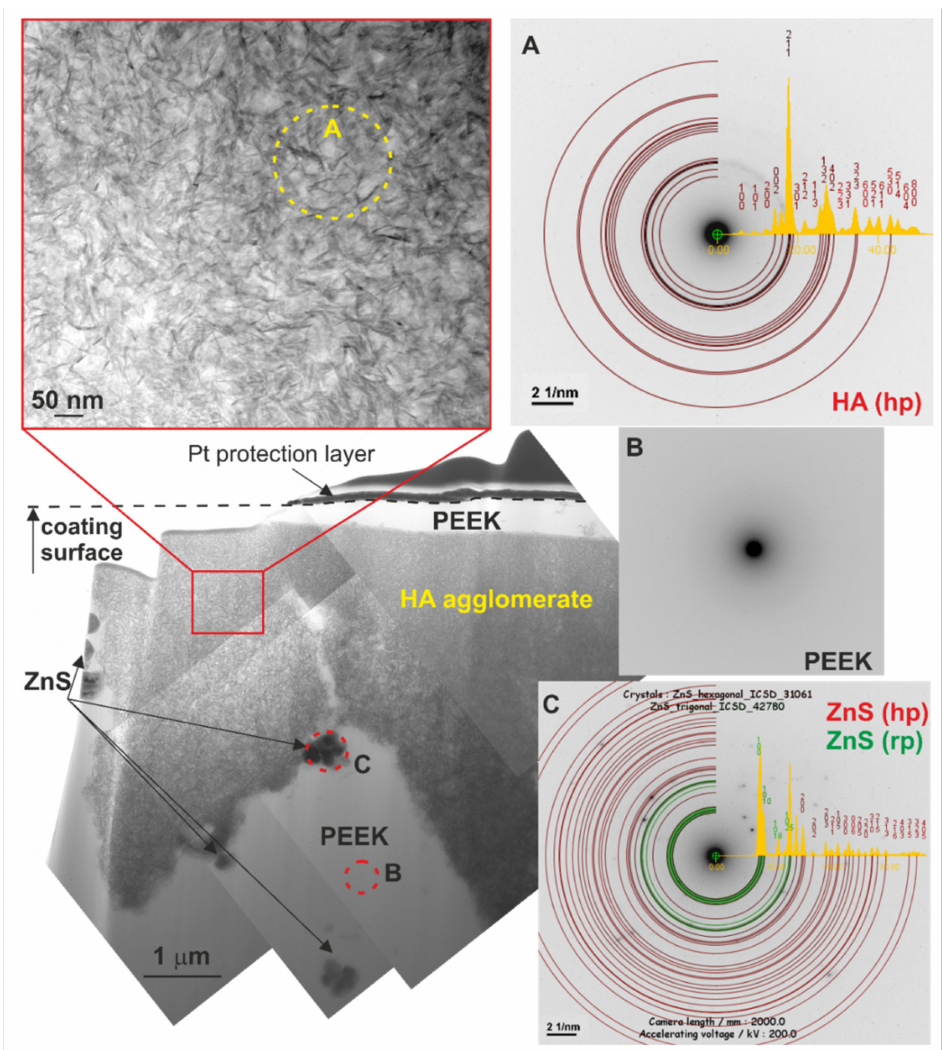
Figure 11. Microstructure of the n-HA/ZnS/S-PEEK coating on the cross-section and diffraction pat- terns ( A – C ) from the traverse sections of the area indicated in the figure and their interpretation,